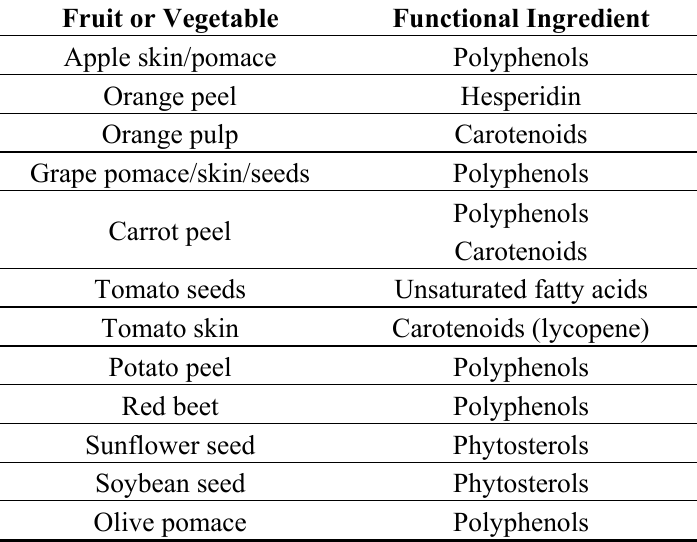
Table 2. Functional ingredients from fruit and vegetable processing co-products